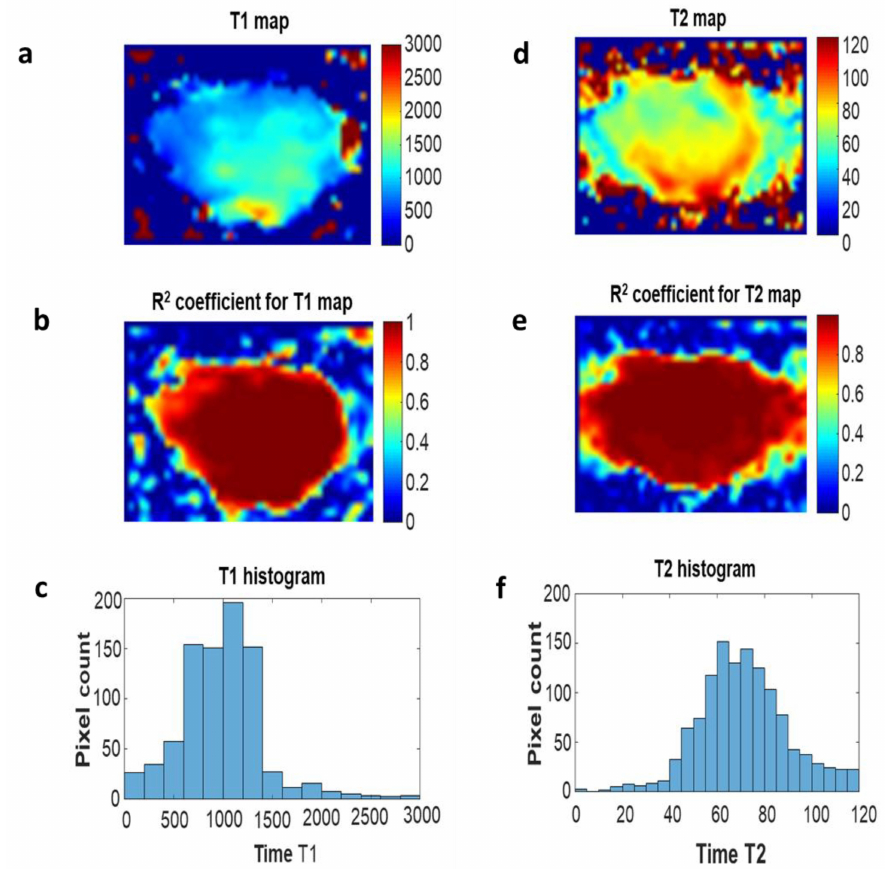
Figure 5. ( a ) Distribution of longitudinal relaxation time T 1 values in the prostate tissue section after PDT with 0.4 mM RB; ( b ) fit factor R 2 distribution; ( c ) a histogram of the values of T 1 times determined from the image ( a ); ( d ) distribution of T 2 transverse relaxation time values in the prostate cancer tissue section after PDT with 0.4 mM RB; ( e ) the distribution of the alignment factor, R2; ( f ) a histogram of the T 2 time values determined from the image ( d